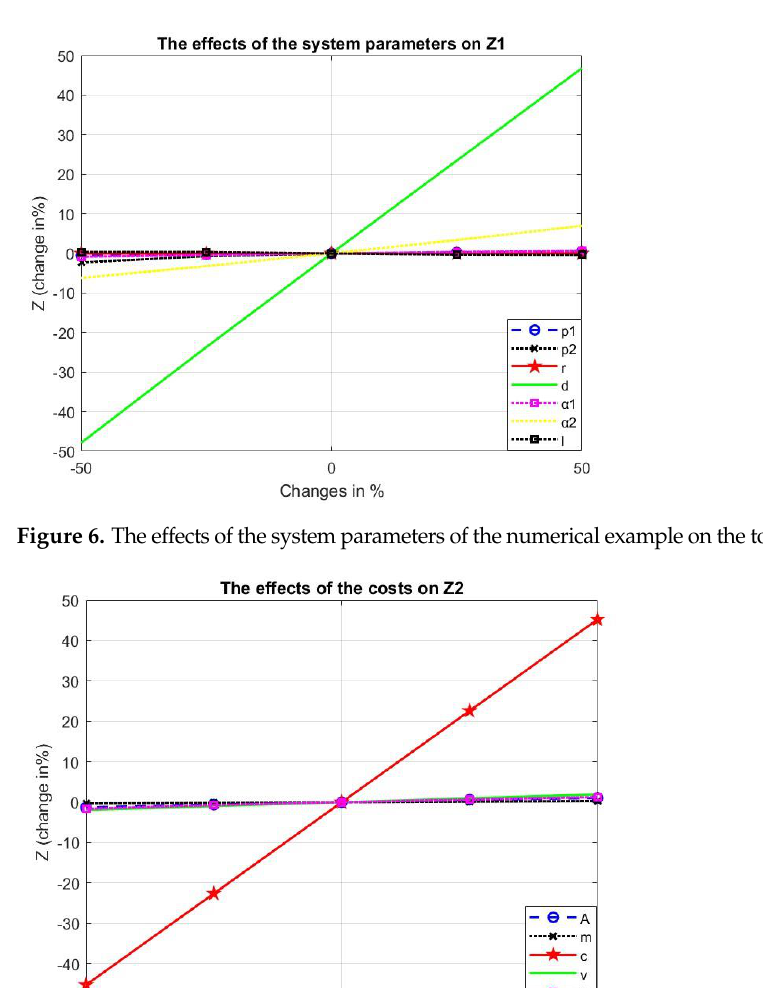
Figure 5. The effects of the costs of the numerical example on the total cost of the first model.